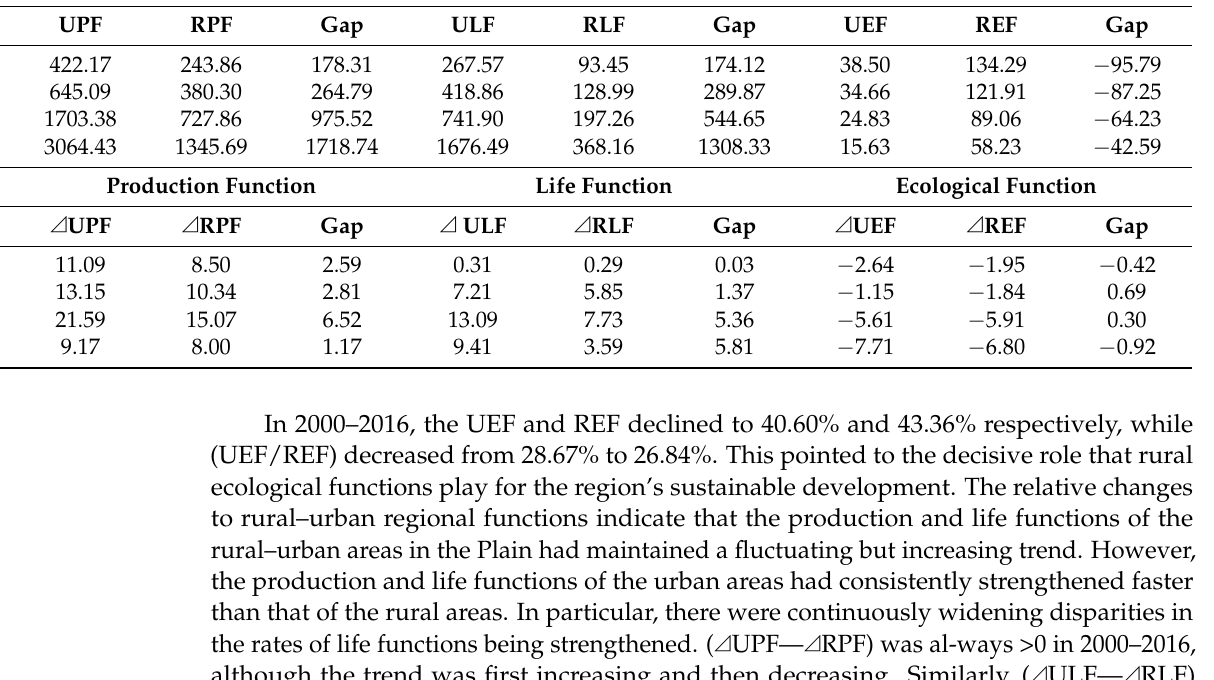
Table 5. Comparison of the absolute and relative changes between urban and rural territorial function in Jianghan Plain from 2000 to 2016 (10,000 yuan/km 2 ). Production Function Life Function Ecological